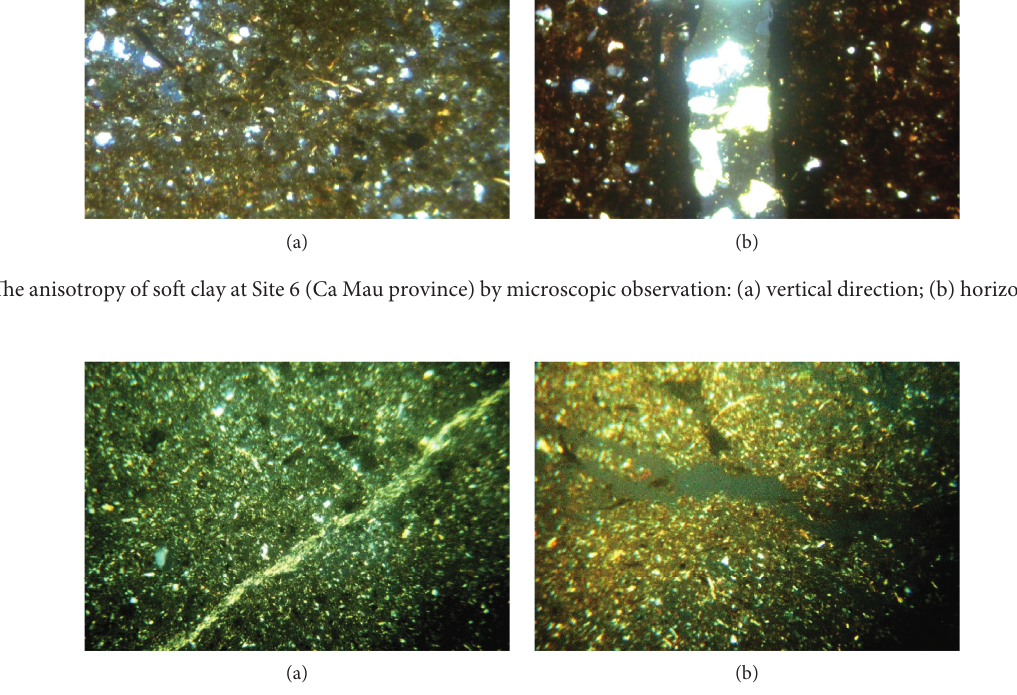
Figure 8: The anisotropy of soft clay at Site 4 (Soc Trang province) by microscopic observation: (a) vertical direction; (b) horizontal direction.